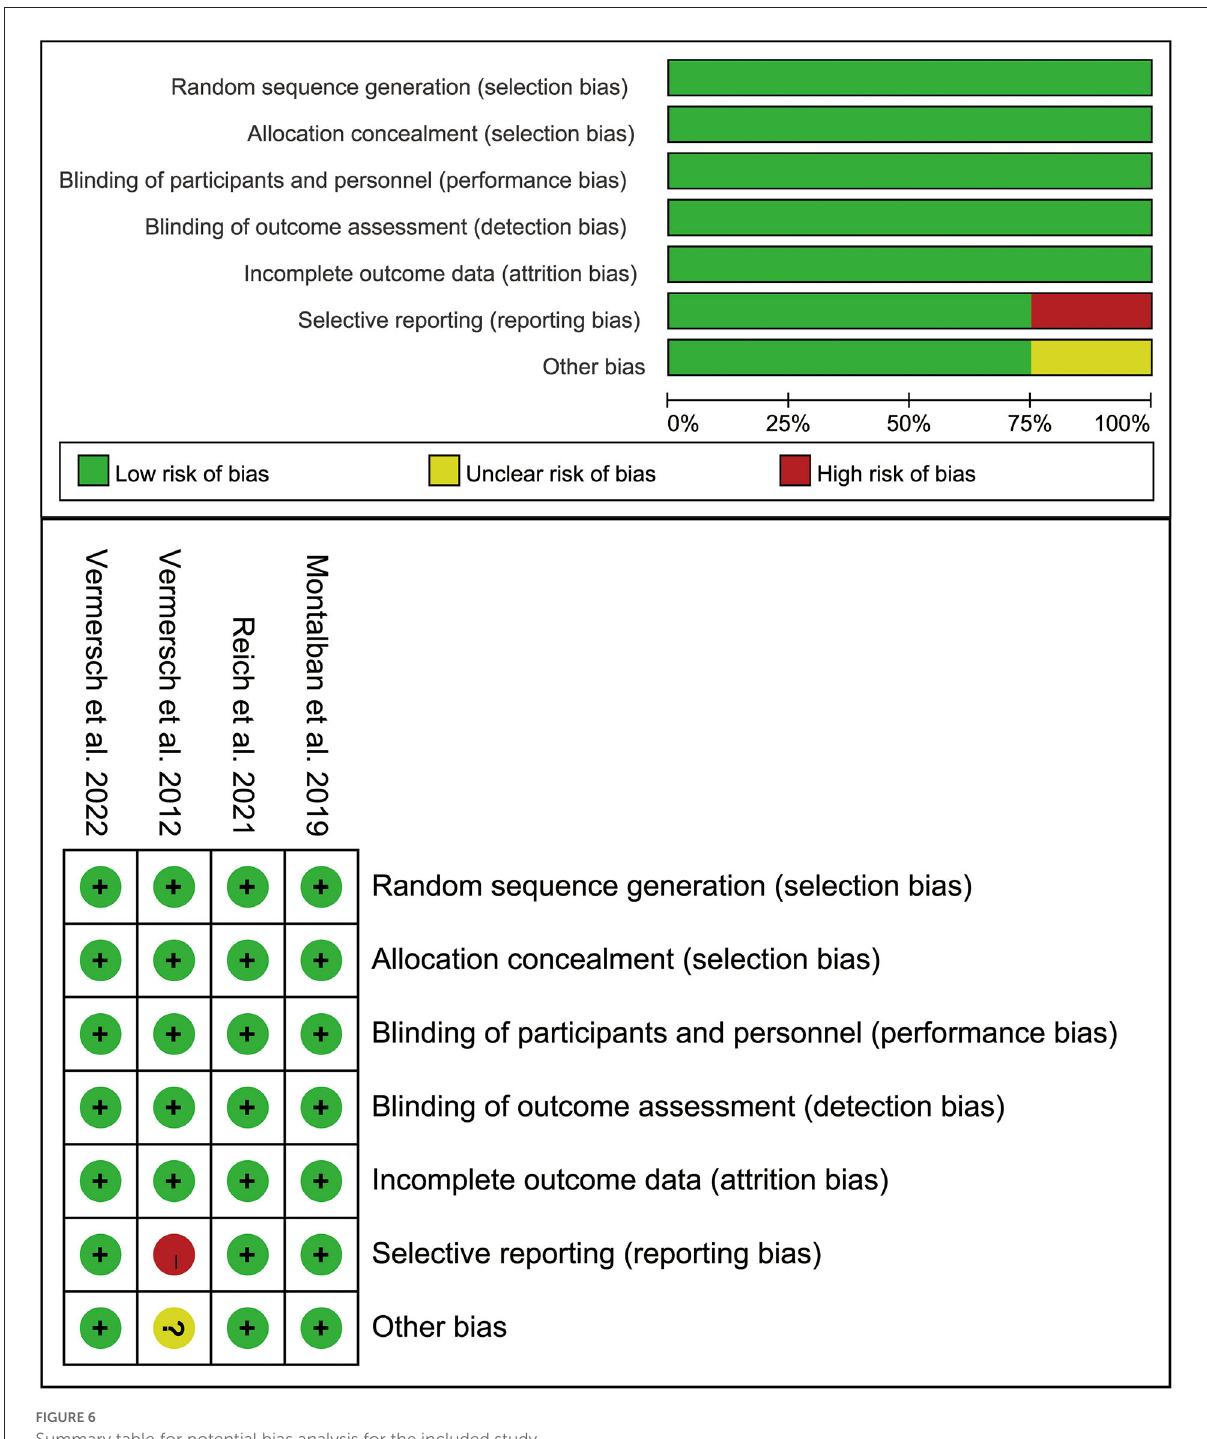
FIGURE6 Summary table for potential bias analysis for the included study.